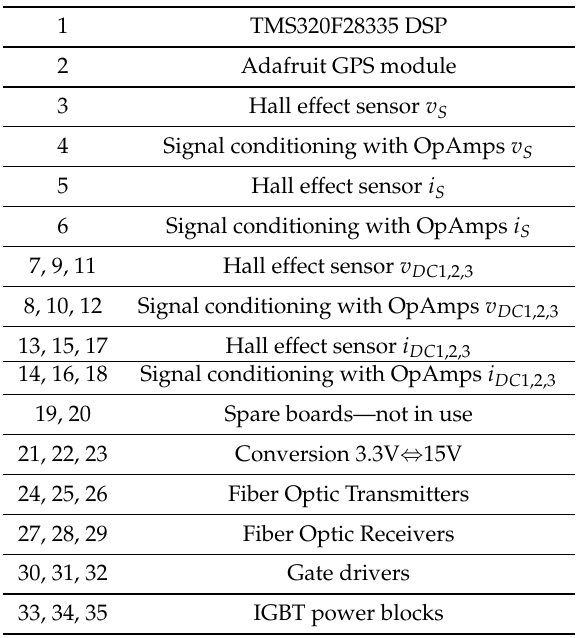
Table 2. Identification of the elements in the test setup of Figure 11.